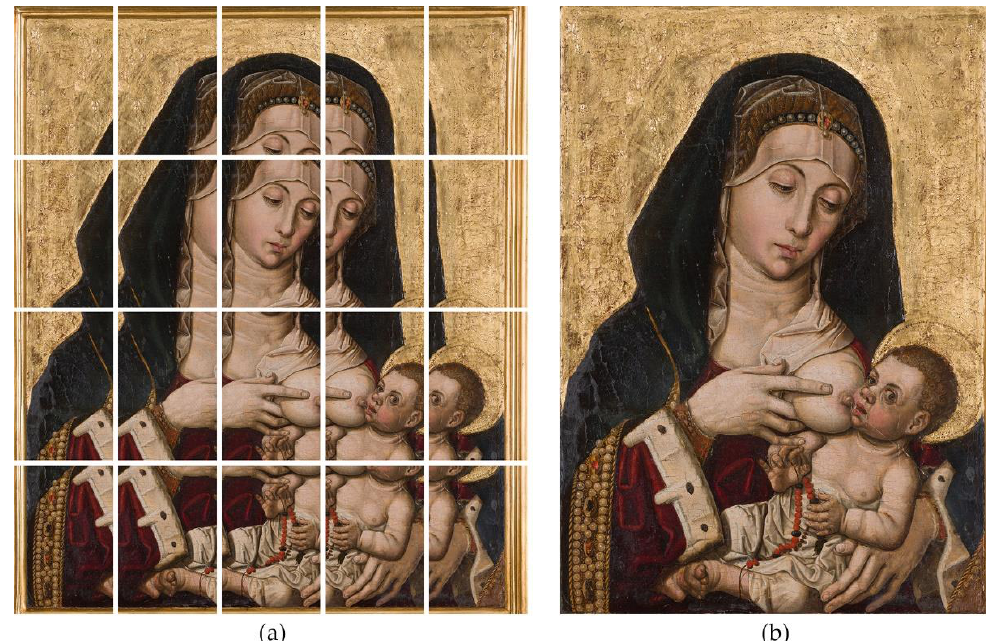
Figure 16. ( a ) Set of 20 pictures taken during the gigapixel capture. ( b ) Stitched Gigapixel Image.